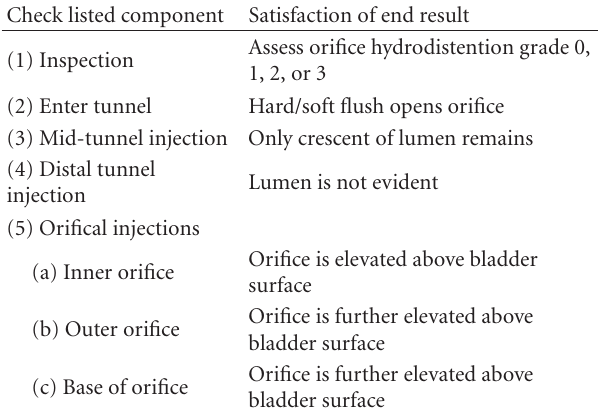
Table 1: Checklist inventory of assessment of ureteral orifice recon- struction and desired end result for each